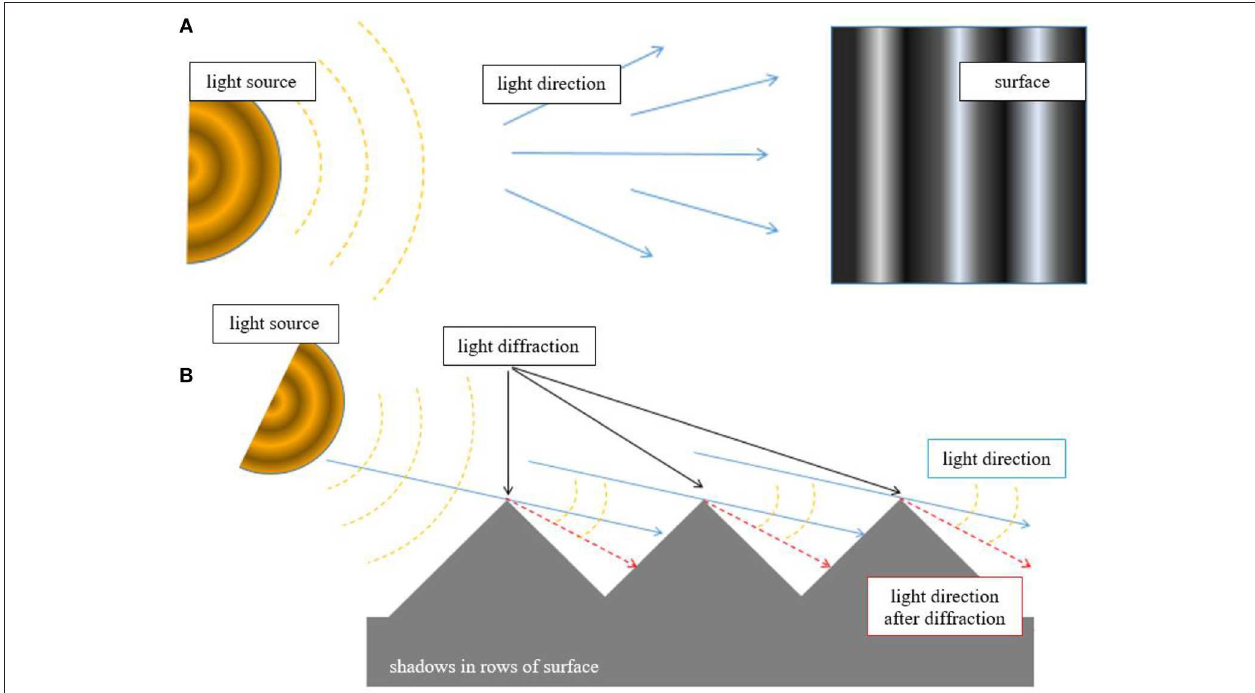
FIGURE 3 | The diagram of scattered light falling on the tested surface: (A) the direction of the light falling on the surface and (B) light diffraction at the tops of the sample.